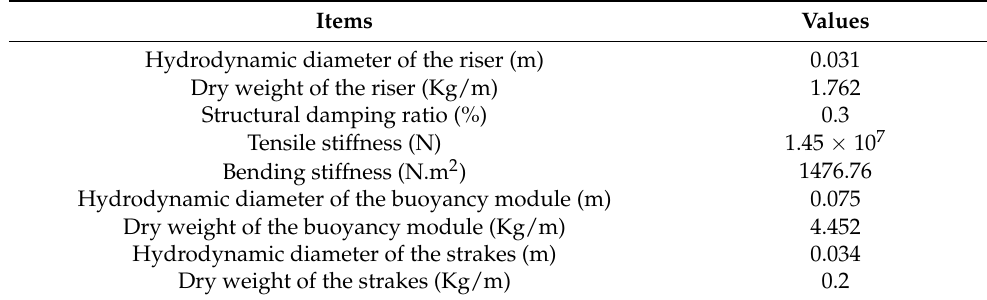
Table 1. Parameters of the riser model.